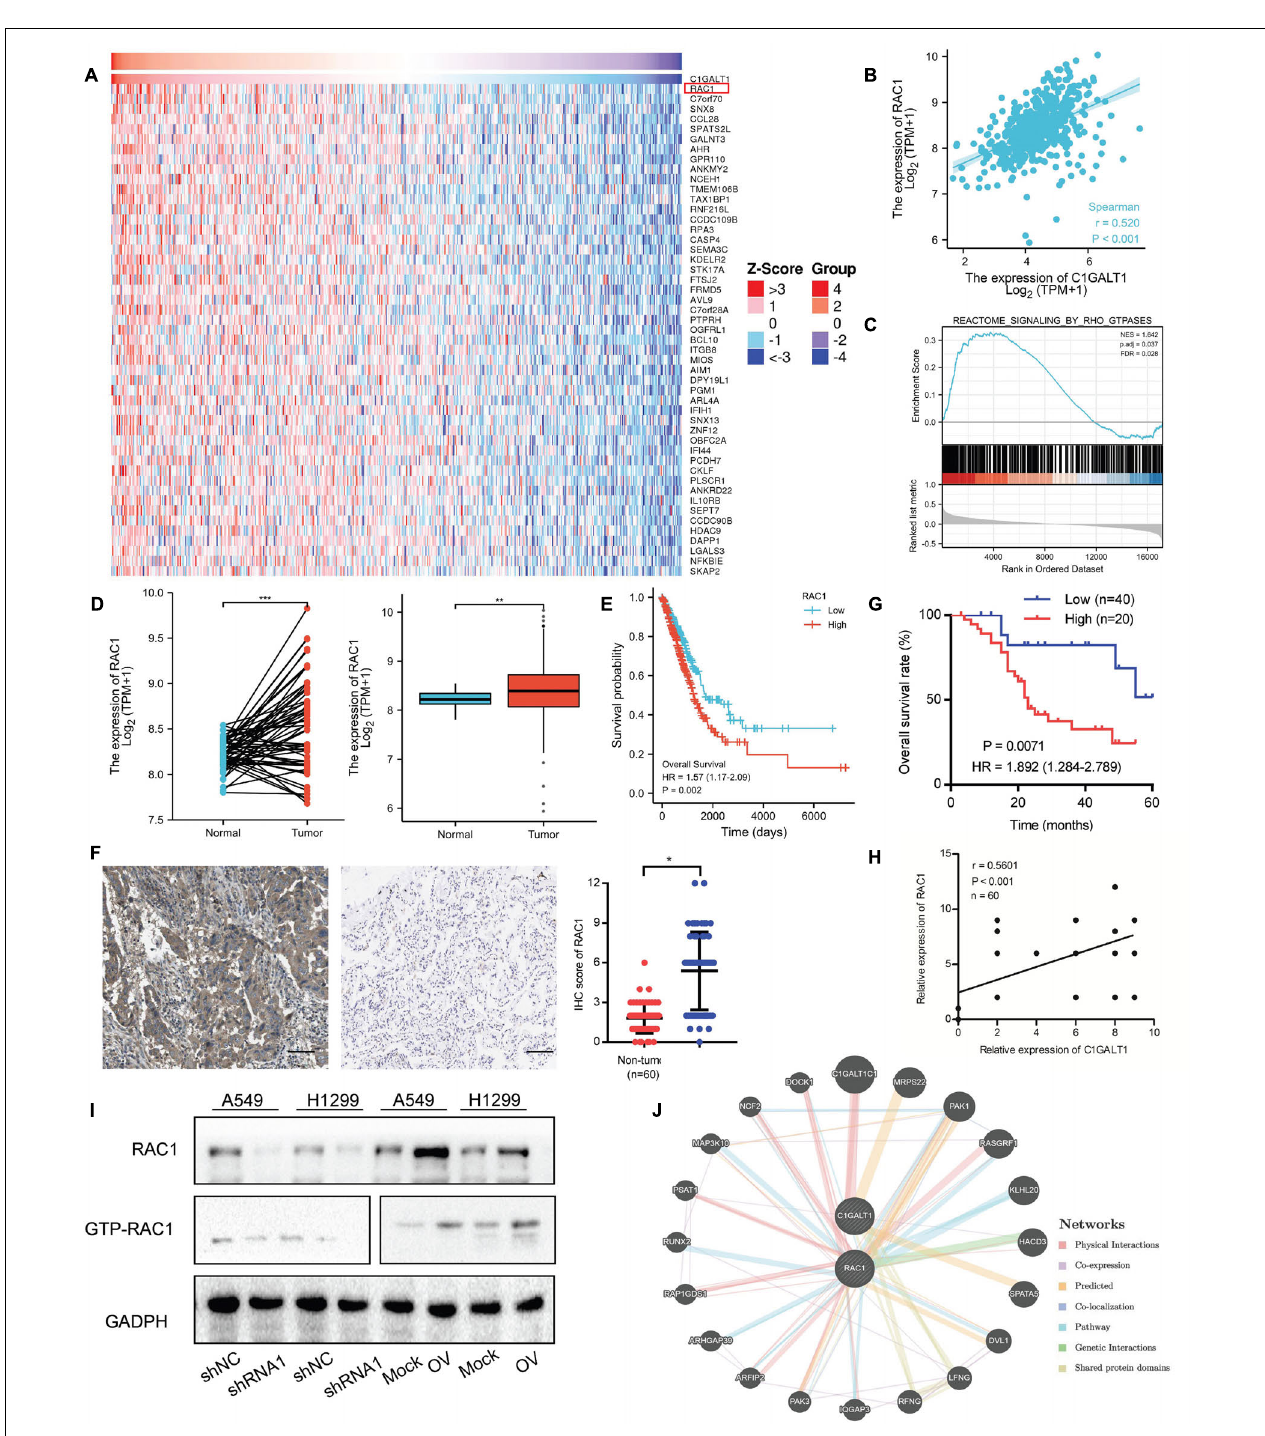
FIGURE 7 | RAC1 expression is positively regulated by C1GALT1 in LUAD. (A) Heat maps showing the top 50 genes positively correlated with C1GALT1 in TCGA-LUAD samples. (B) Correlation between RAC1 and C1GALT1 in TCGA-LUAD samples. (C) GSEA analysis of C1GALT1-associated genes in TCGA-LUAD samples. (D) RAC1 expression in paired (left) or unpaired (right) LUAD tissues and normal lung tissues from the TCGA database. (E) Survival analysis of RAC1 in LUAD from the TCGA database. (F) Analysis of RAC1 expression by IHC in clinical LUAD samples. Scale bar: 100 µ m. (G) Pearson correlation analysis of RAC1 with C1GALT1 expression in clinical LUAD samples. (H) Overall survival analysis of LUAD patients based on RAC1 expression in clinical samples. (I) The effect of C1GALT1 on RAC1 expression in LUAD cells was detected by Western blot. (J) The network between RAC1 and C1GALT1 was predicted by the online GeneMANIA tool. Mock, cells transfected with empty plasmid; OV, cells transfected with C1GALT1 overexpression plasmid; shNC, cells infected with negative control shRNA; shRNA1, cells infected with C1GALT1 shRNA1. Data are expressed as mean ± SD. * p < 0.05; ** p < 0.01; *** p < 0.001.